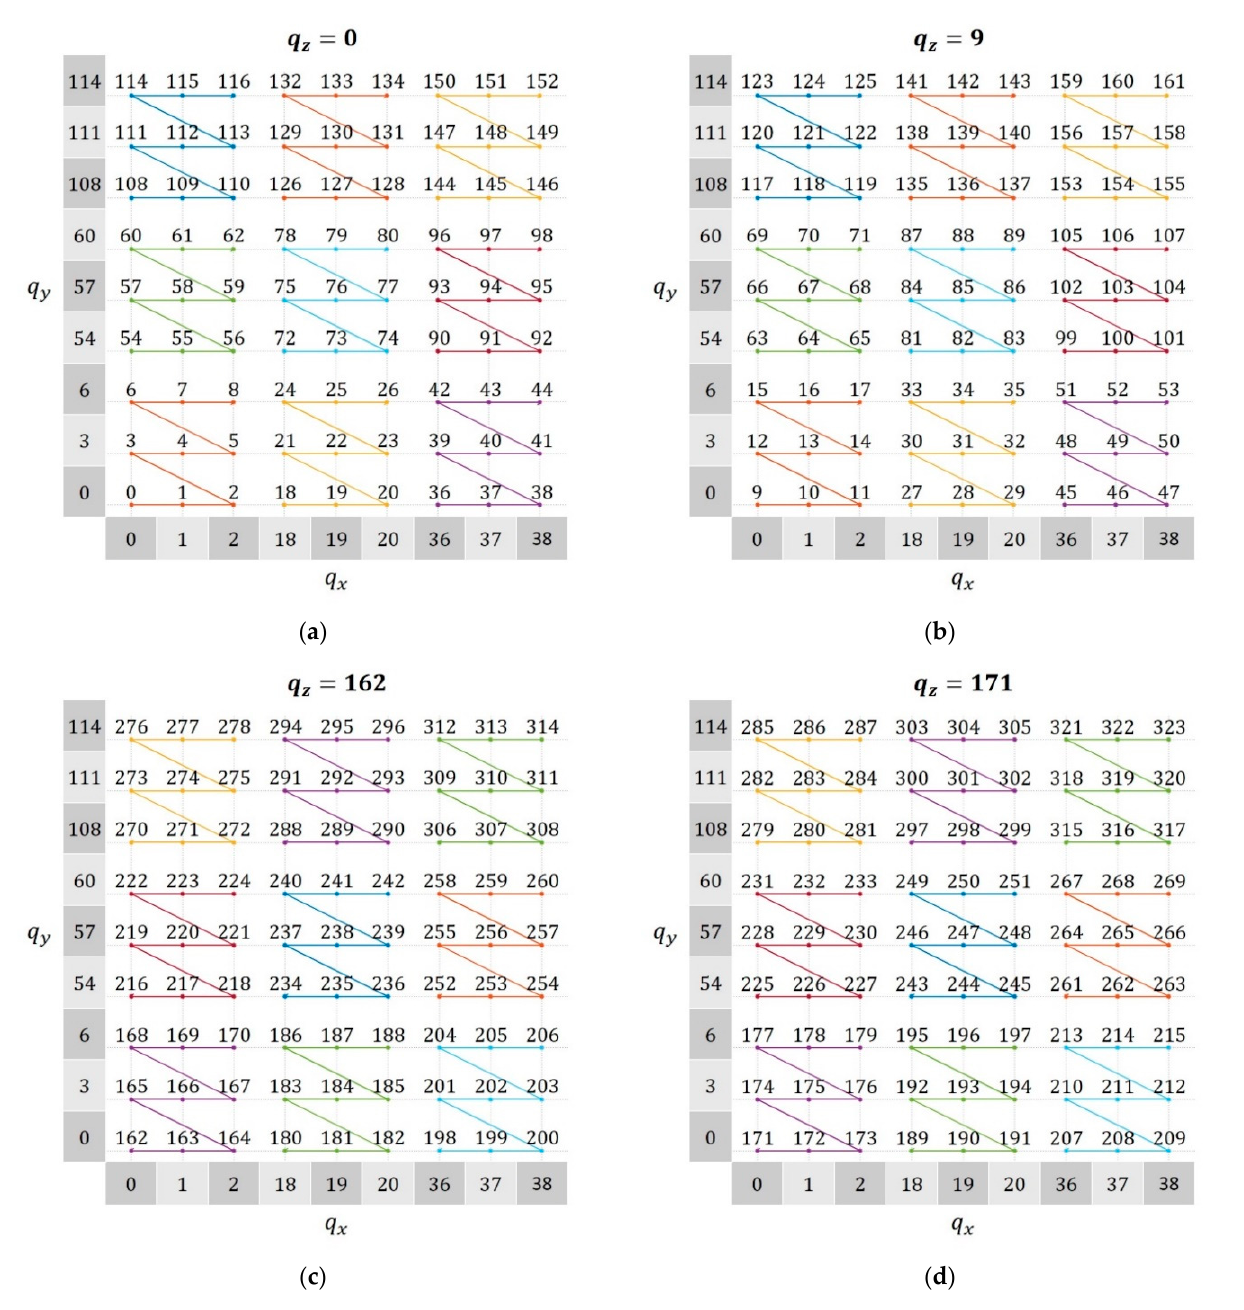
Figure 4. Child subimage indices 𝑐 at their corresponding locations over the modified Morton order curve with the recurrent sequences 𝑞 (cid:3051) and 𝑞 (cid:3052) displayed on the axes and with ( a ) 𝑞 (cid:3053) = 0, ( b ) 𝑞 (cid:3053) = 9, ( c ) 𝑞 (cid:3053) = 162, and ( d ) 𝑞 (cid:3053) = 171.